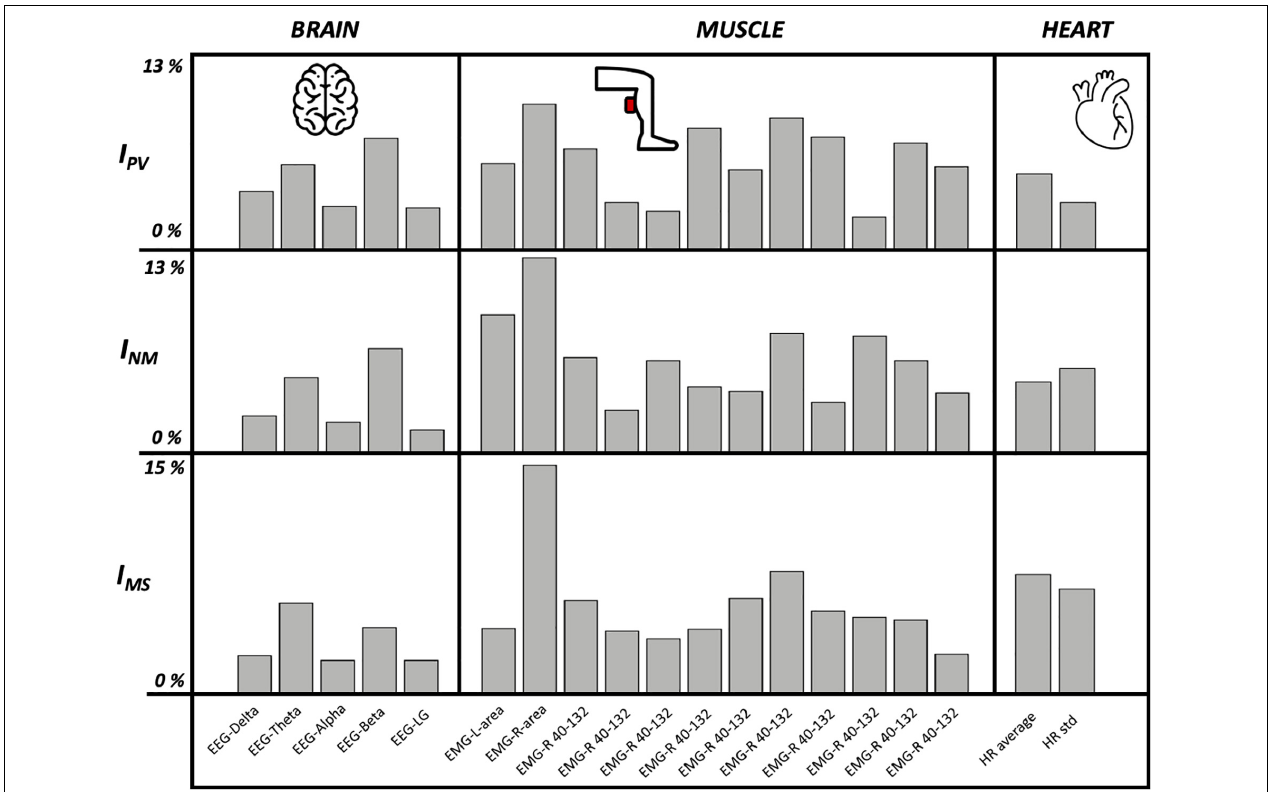
FIGURE 3 | Brain, muscle, and heart feature importance for I PV , I NM , and I MS using Random Forest algorithm.